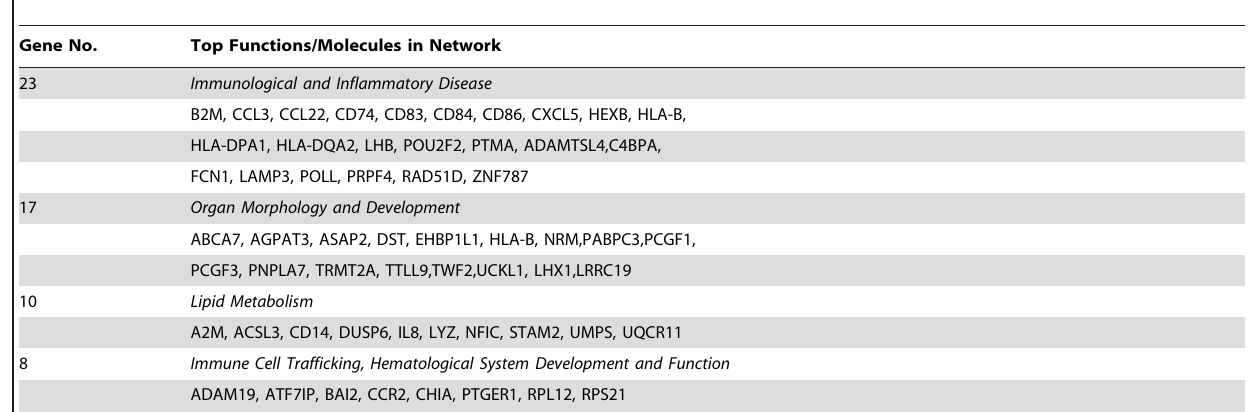
Table 3. Functional network analysis of significant genes involved in DC differentiation*.